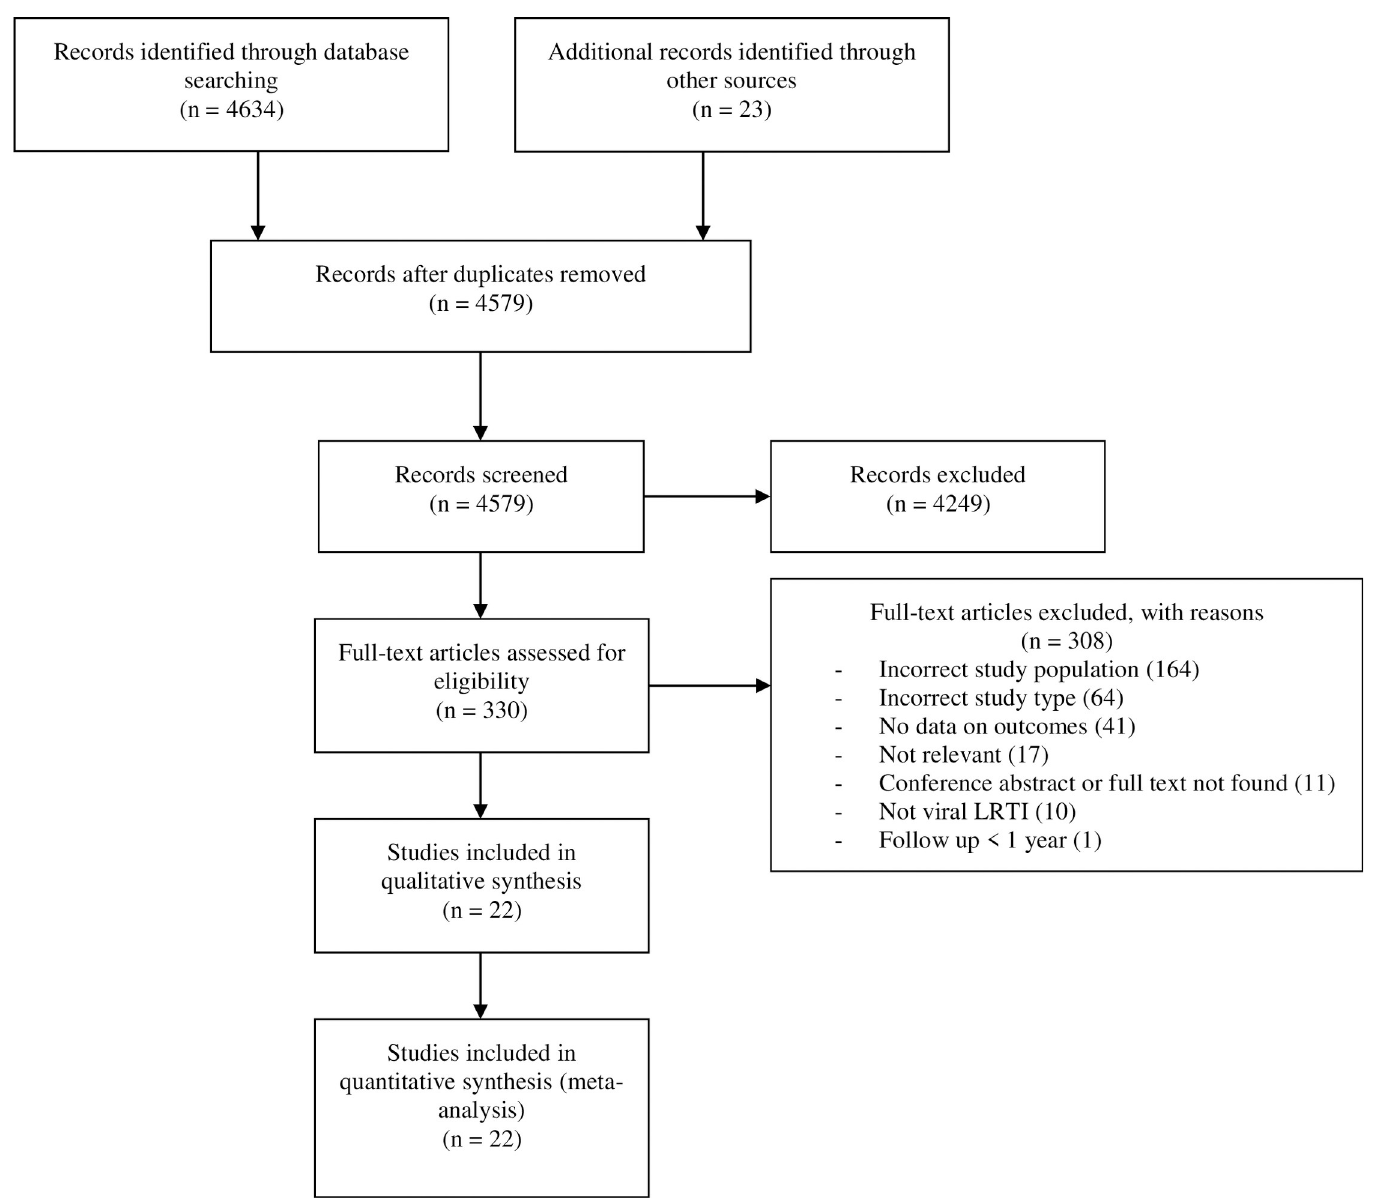
were published between 1981 and 2017.The individual NOS score from the included studies are presented in S4 Table. Comparison of reference cases with controls The frequency of post-LRTI atopy was similar between reference cases and controls in most categories (atopy diagnosed with SPT, OR = 1.2, 95% CI = 0.7–2.0; atopy diagnosis unknown/ not reported, OR = 0.7, 95% CI = 0.4–1.3; atopic dermatitis, OR = 1.2, 95% CI = 0.9–1.6; pol- lens, OR = 0.8, 95% CI = 0.3–2.7; food allergy, OR = 0.8, 95% CI = 0.3–2.5; and house dust mite, OR = 1.1, 95% CI = 0.6–2.2) (Fig 2, S1 Fig). With regard to atopy assess by serum test,